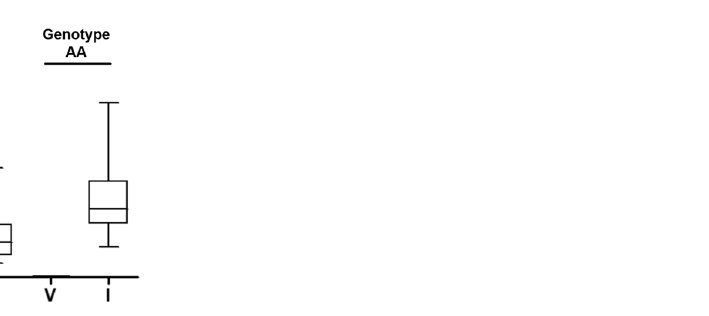
Figure 2. The plasma concentrations of complement factor H (CFH) variants with valine and isoleucine by measuring multiple reaction monitoring assays according to CFH single nucleotide polymorphism rs 800292. V, valine; I,